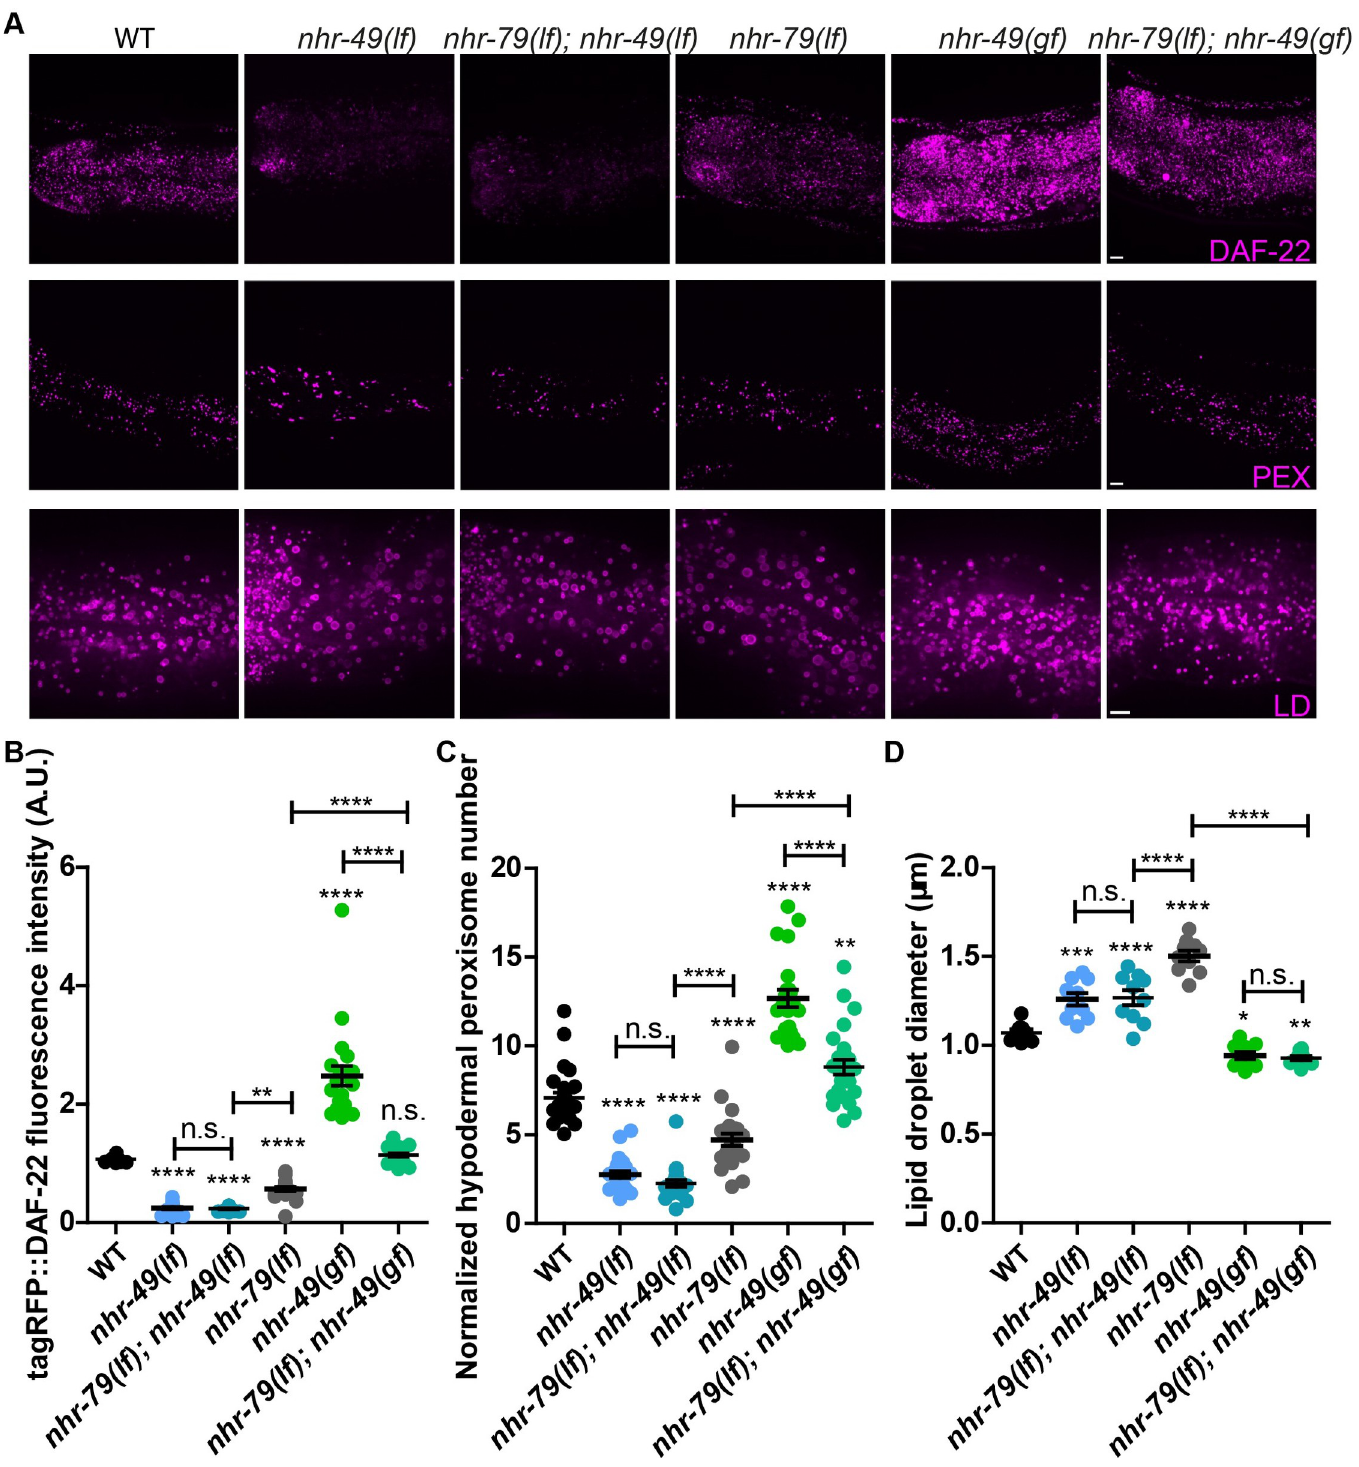
Fig 7. Functional interaction of NHR-49 and NHR-79. (A) Representative images showing the fluorescence of tagRFP::DAF-22 ( hj234 ) (top), hypodermal peroxisomes labeled with tagRFP::PTS1( hjSi486 ) (middle), and intestinal lipid droplets labeled with DHS-3::mRuby ( hj200 ) (bottom). (B) Quantification of fluorescence intensity of tagRFP::DAF-22. n > 20 for each group. (C) Quantification of hypodermal peroxisomes normalized with the length of the worm in the field of view. n > 20 for each group. (D) Quantification of lipid droplet size in the second intestinal segment. n = 10 for each group. In each plot, mean ± SEM of each group is shown. For all statistical tests, � p < 0.05, �� p < 0.01, ��� p < 0.001, ���� p < 0.0001, the actual p-value is displayed when p is between 0.05 and 0.1, n.s. (not significant) p > 0.1 (two-way ANOVA with Tukey’s multiple comparisons test). PEX, peroxisome; LD, lipid droplet. Scale bar = 5 μ